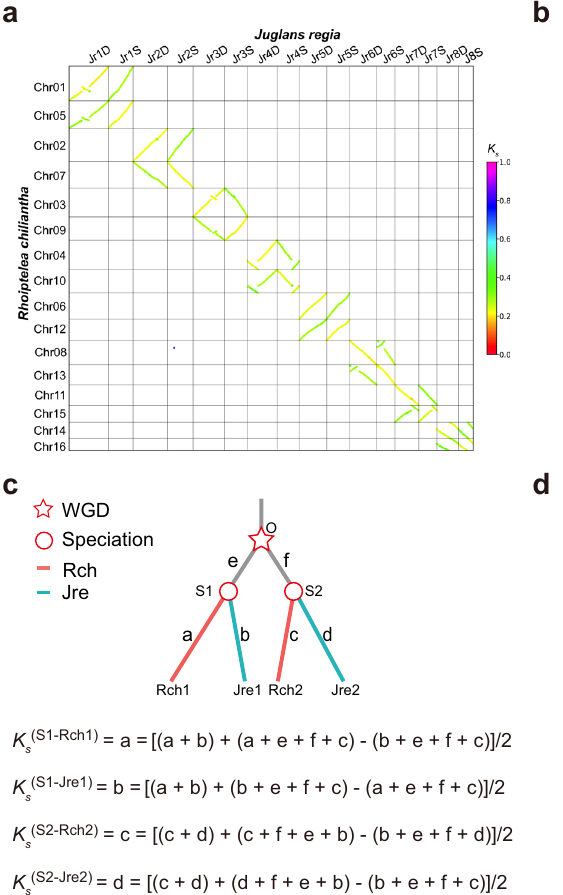
bootstrap values ≥ 80. The phylogenetic trees on the left (2464 trees) support a sharedWGD,thoseontheright(123trees)anindependentWGD.Theredstarin( b ) and ( c ) marks the WGD event, and the red circles indicate speciation events. c Relativerate tests used toestimatethe evolutionaryrateofthe differentspecies. Rch1 and Rch2 arethe WGD-derived homoeologs of R. chiliantha , Jre1 and Jre2 are the WGD-derived homoeologs of J. regia ; Rch1-Jre1 and Rch2-Jre2 are the ortholo- gousgenepairsduetospeciation. K s (S1-Rch1) istheexpectednumberofsubstitutions per synonymous site in Rch1 since the speciation event (labeled S1), and other K s estimatesaresimilarlyde fi ned. d Acomparisonofthemolecularevolutionaryrates for R. chiliantha and J. regia using the two-tailed two-sample Wilcoxon rank-sum test (Mann – Whitney test). *** P <0.001. Source data are provided as a Source Data fi